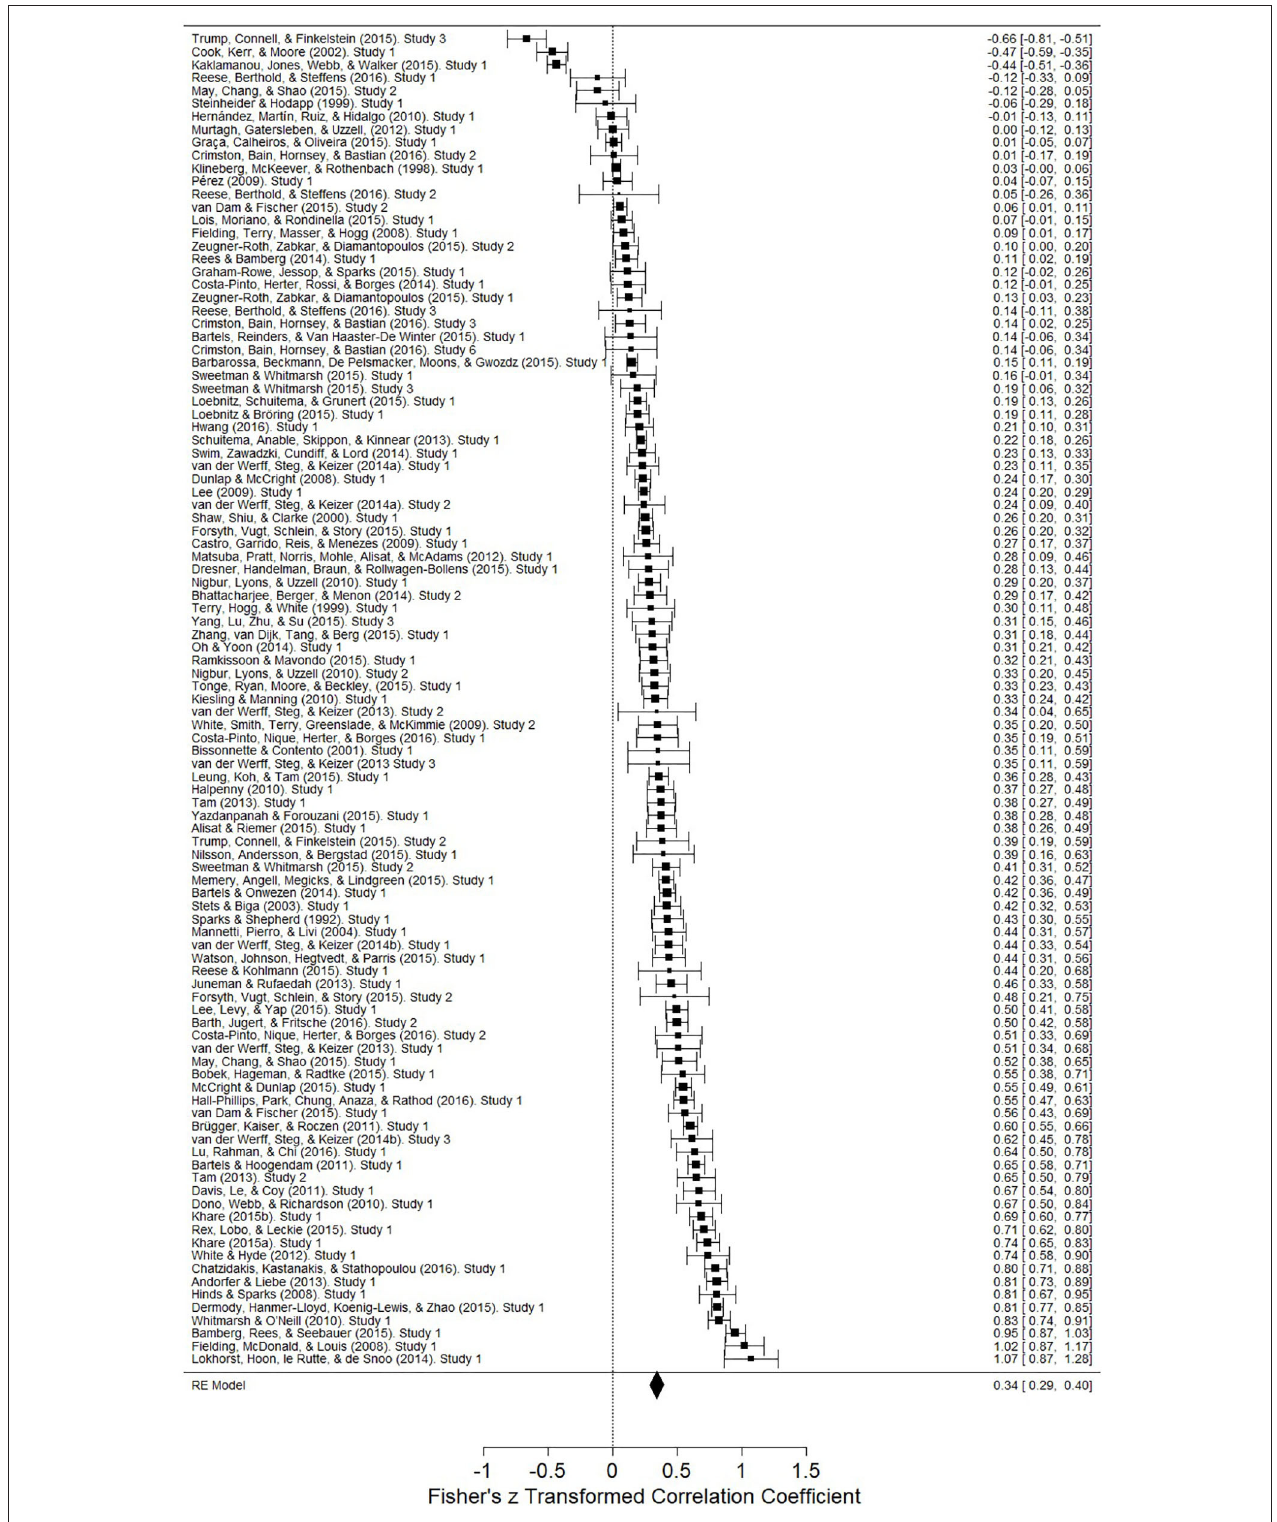
FIGURE 2 | Forest plot of Pearson’s r regression coefficient, associated 95% confidence intervals (CI) for studies in a random-effects meta-analysis regression.